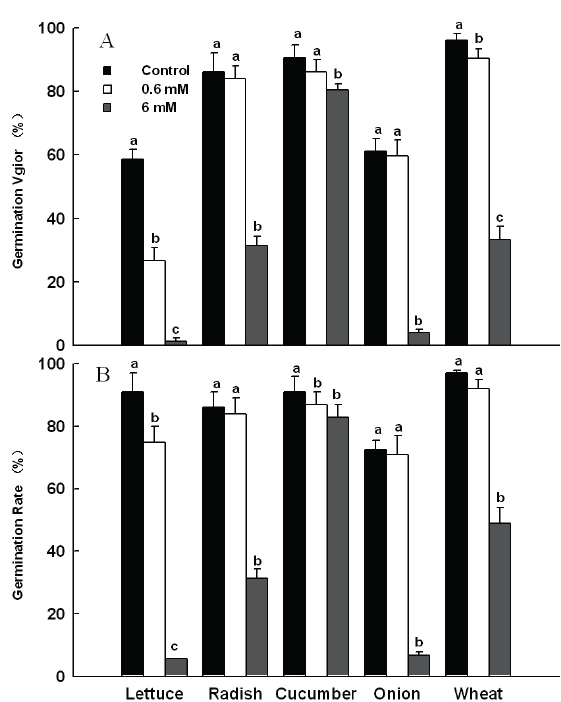
Figure 5. Effects of 4,8-DHT on five plant seed germination: ( A ) germination vigor, ( B ) germination rate. Data are the mean ± SD values (n = 3 per group). Final means with different letters are significantly different at p = 0.05.